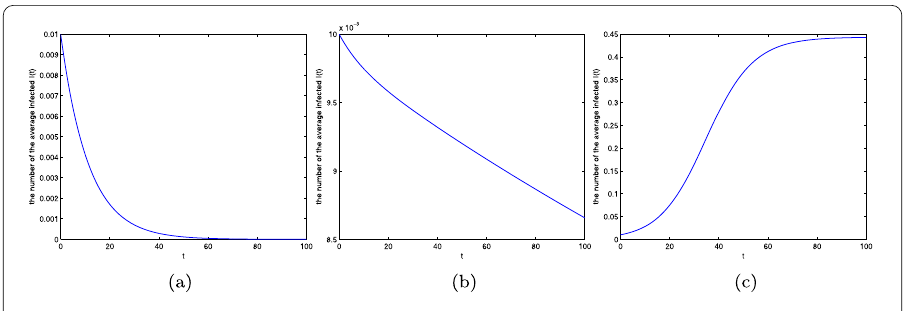
(cid:5) n k =1 p ( k ) I k ( t ) with respect to ( a ) R 0 < 1, ( b ) R 0 = 1, and ( c ) R 0 > 1